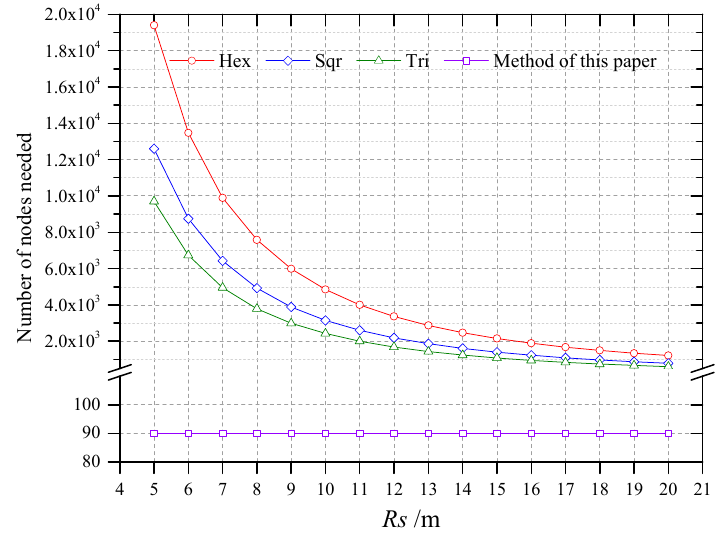
Figure 20. The number of nodes needed with different deployment methods.